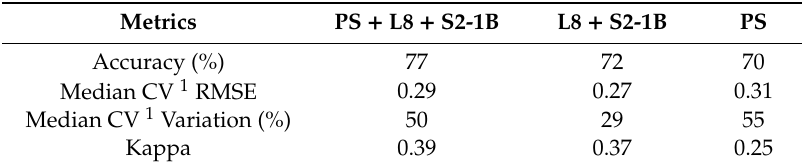
Table 2. Metrics when di ff erent types of imagery was used. Model combining the PS imagery with coarser providers yielded better results than PS only-based model.